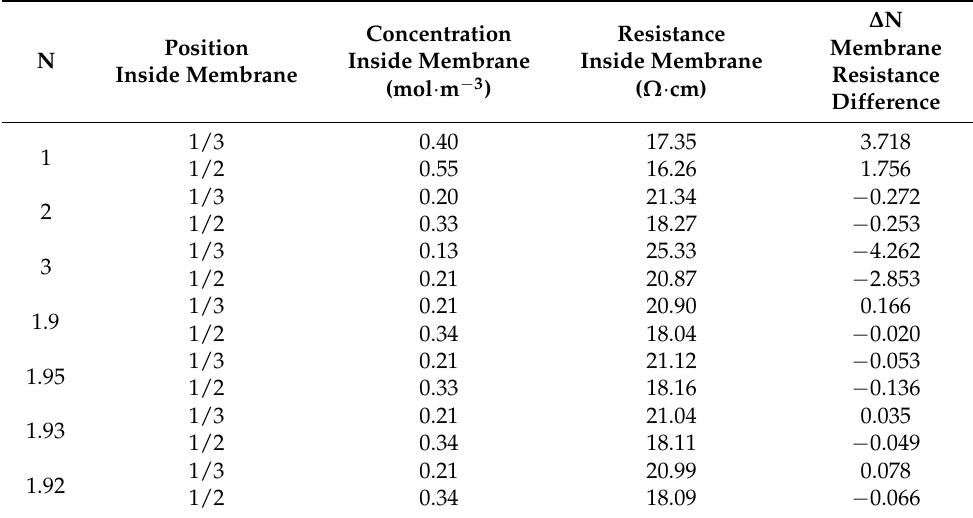
from the real impedance under different